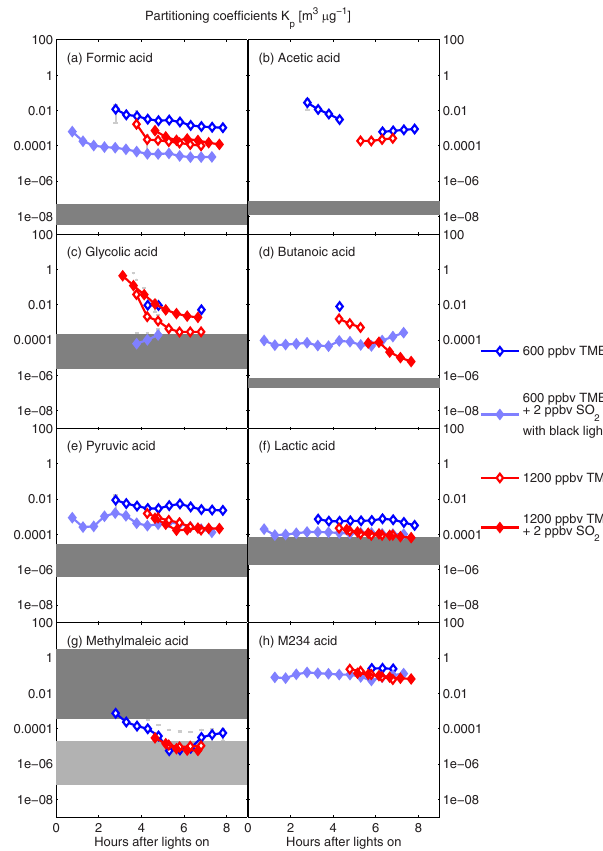
Figure 9. Time-dependent partitioning coefficients, K p (in m 3 µg − 1 ). Grey areas represent the expected range of values for different saturation vapour pressure estimations. See text for discus- sion. The lower limit corresponds to the smallest value estimated for K p and the upper corresponds to the highest effective partitioning coefficient K p , eff derived, assuming pH=4. In (g) , the light grey area represents the theoretical value range of methylmaleic anhy-